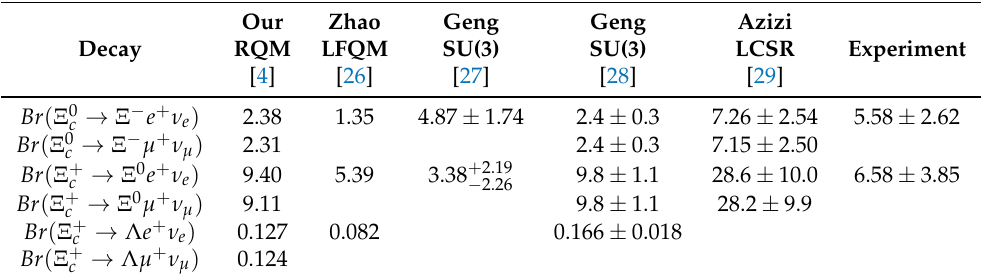
Table 4. Comparison of theoretical predictions for the Ξ c semileptonic decay branching fractions (in %) with available experimental data. Our Zhao Geng Geng Azizi Decay ExperimentRQM LFQM SU(3) SU(3) LCSR [26] [27] [28] [29]